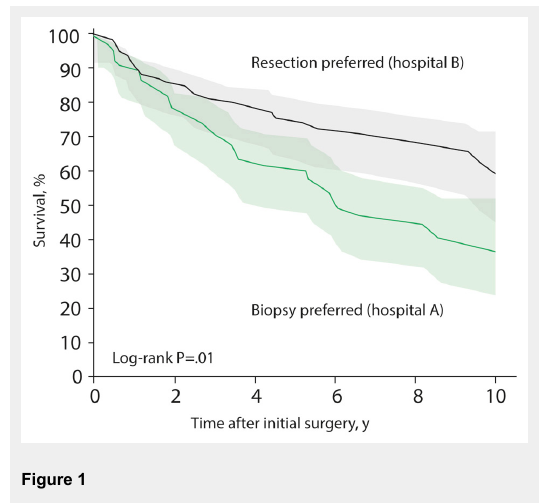
Patient survival according to hospital treatment strategy. Patients treated at a hospital that favoured a pro-active strategy with early radical resection for low-grade glioma had an improved survival time compared with patients treated in a hospital that followed a “wait-and-see” strategy after biopsy [7].